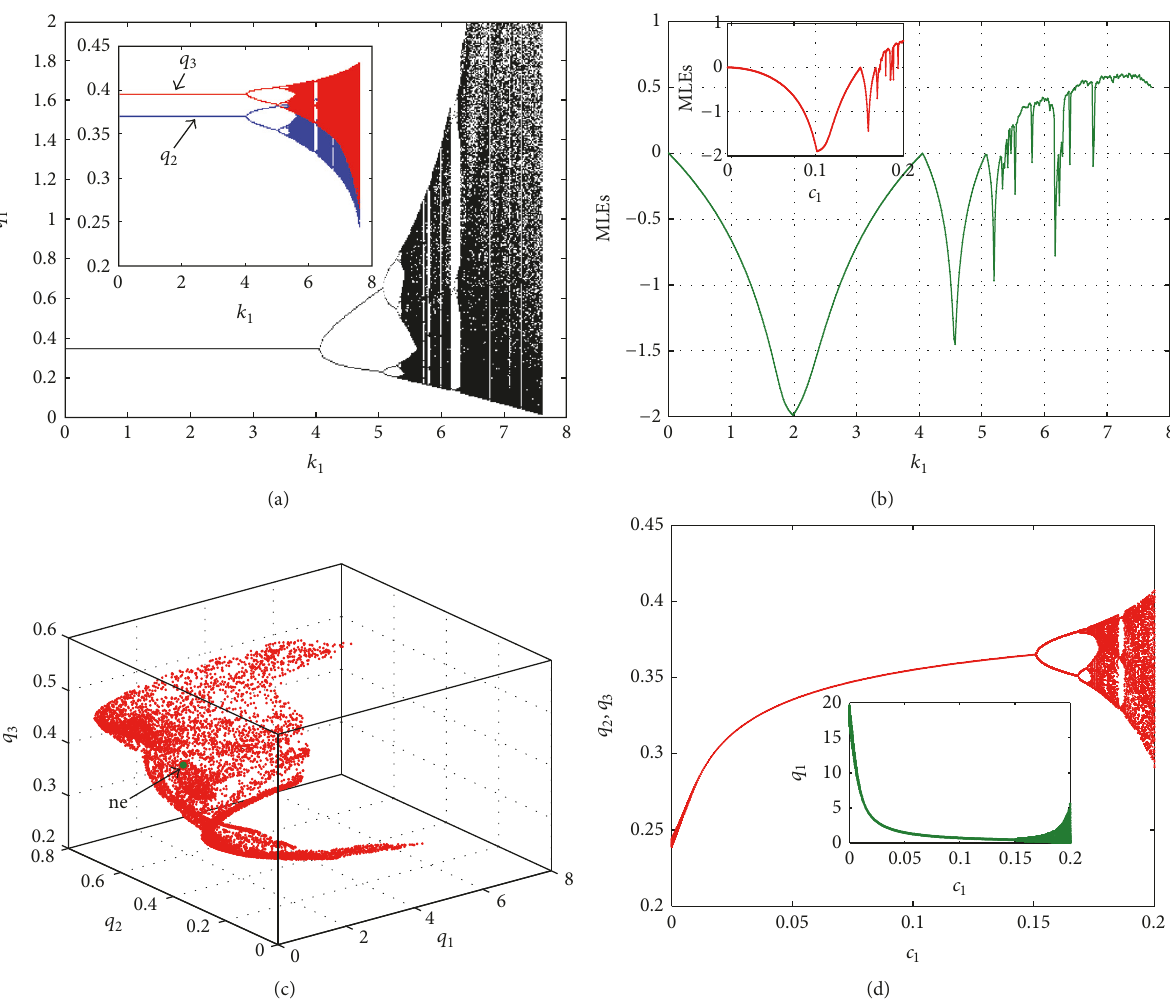
Figure 10: (a) Bifurcation diagram for the case (𝛼 = 0.3) with respect to 𝑘 1 at 𝑐 1 = 0.19 , 𝑐 2 = 0.18 , 𝑐 3 = 0.17 , 𝑞 0,1 = 0.11 , 𝑞 0,2 = 0.12 , and 𝑞 = 0.13 . (b) The maximum Lyapunov exponents with respect to 𝑘 3,0 𝑐 = 0.18 , and 𝑐 = 0.17 . (d) Bifurcation diagram for the case (𝛼 = 0.3) with respect to 𝑐 2 3 and 𝑞 3,0 = 0.13